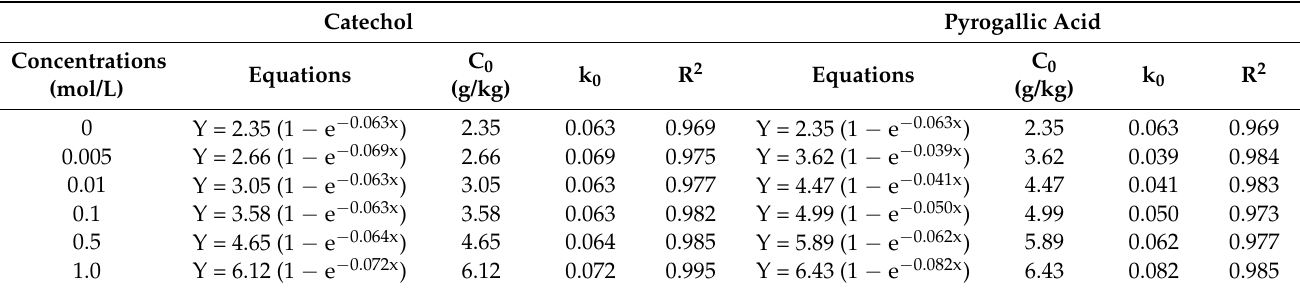
Table 1. Single exponential fitting equation for the soil mineralization process.